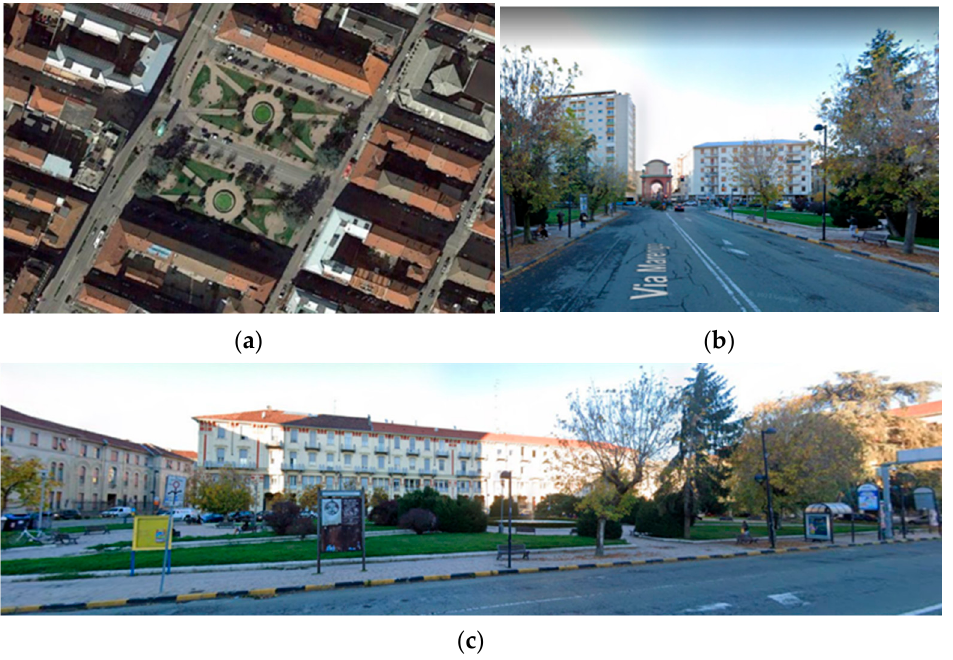
Figure 9. The photos represent Piazza Genova/Matteotti ( a ) from an aerial perspective, showing the structure of the two small parks on the sides of the central axis of Via Marengo ( b ), that continues in the direction of Via Dante, from the historical center to the extra-urban areas, starting from the monumental Arch of Marengo; ( c ) from a human-scale perspective, the borders of the parks are lowly densified, mainly defined by small size trees like Acer Negundus (Source: Google Street View).